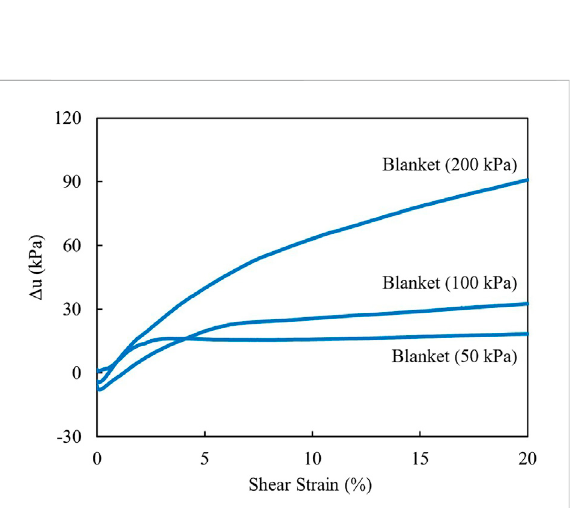
FIGURE 6 Stress-strain behavior from CU direct simple shear tests on CB clay blanket samples.